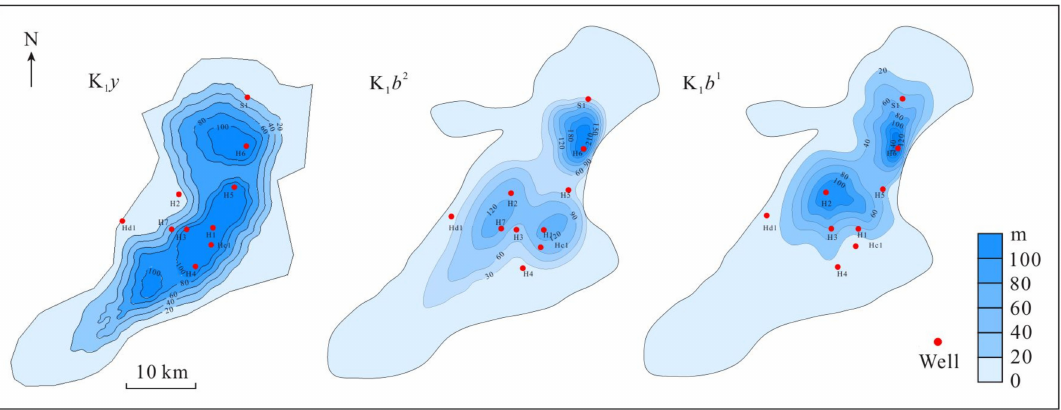
Figure 4. Thickness contour maps of effective source rocks in the Hari